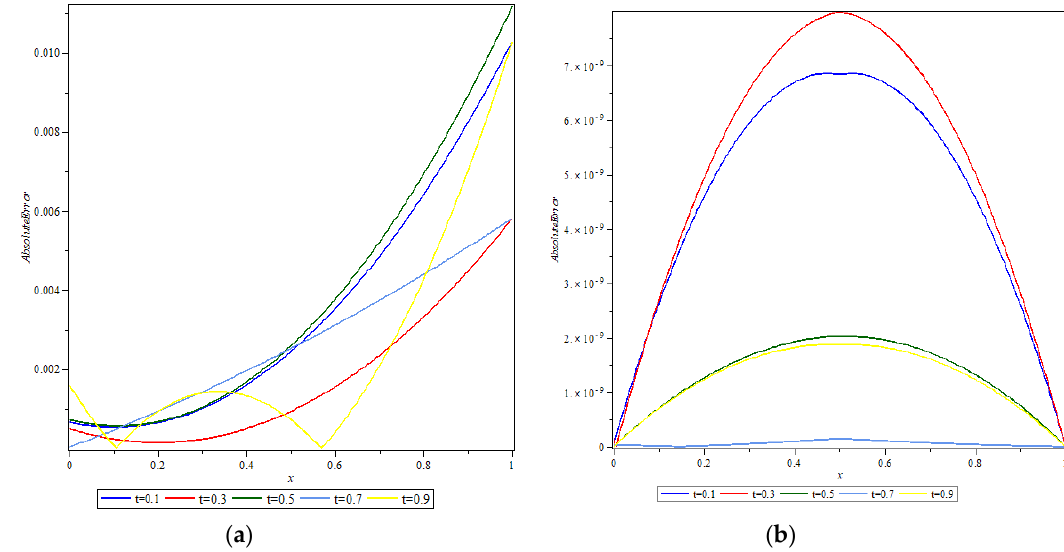
Figure 2. ( a ) The absolute errors | u exactsol − u GWGM | at di ff erent times, when α = 0.90; ( b ) the absolute errors | u exactsol − u GWCM | at di ff erent times, when α =